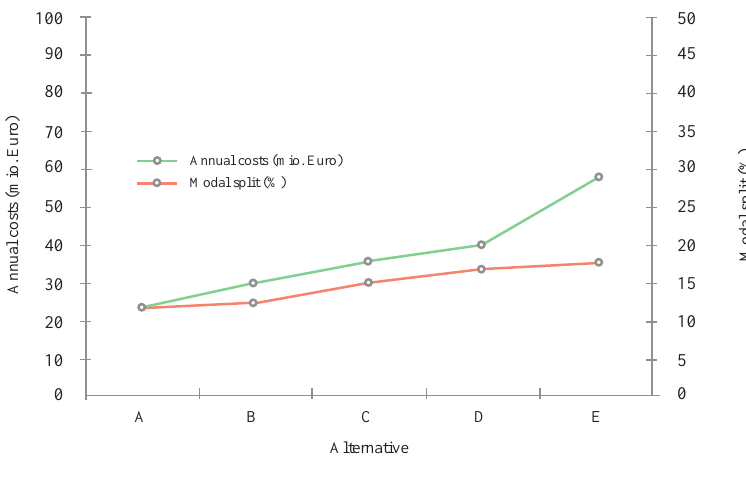
Fig. 5. Modal split versus annual